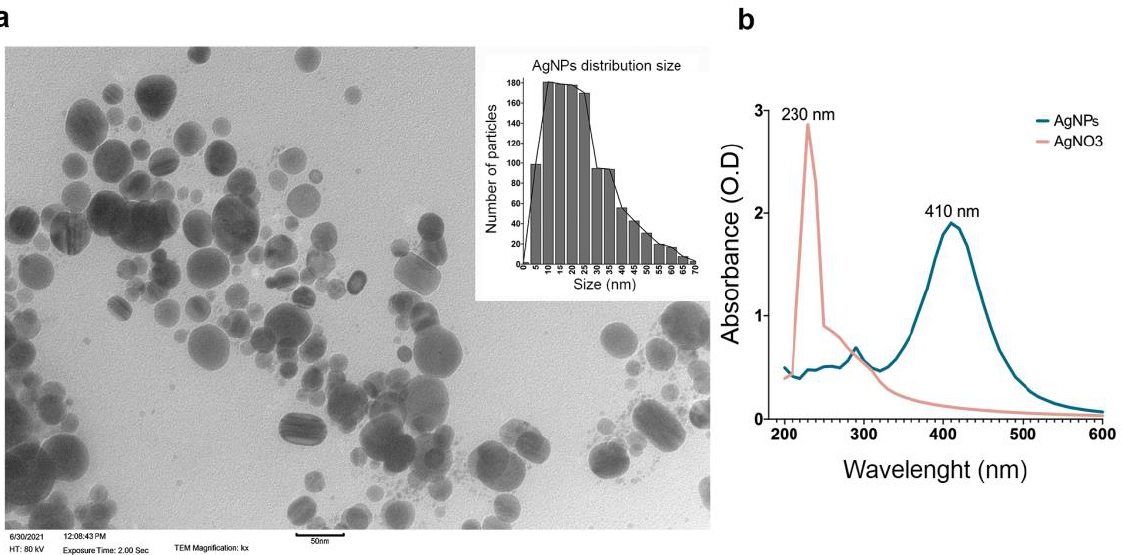
Figure 1. Silver nanoparticles (AgNPs) characterization. ( a ) Transmission electron microscopy of AgNPs. One bar represents 50 nm. AgNPs’ size distribution is shown in the insert. ( b ) UV–Vis profile of AgNPs and AgNO 3 .